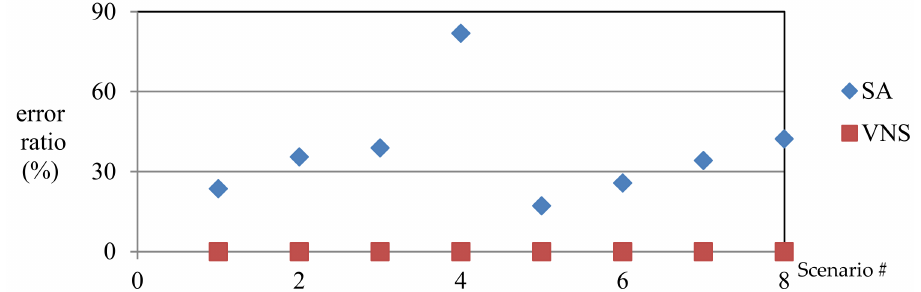
Figure 6. Error ratio of objective value associated with 40 orders.